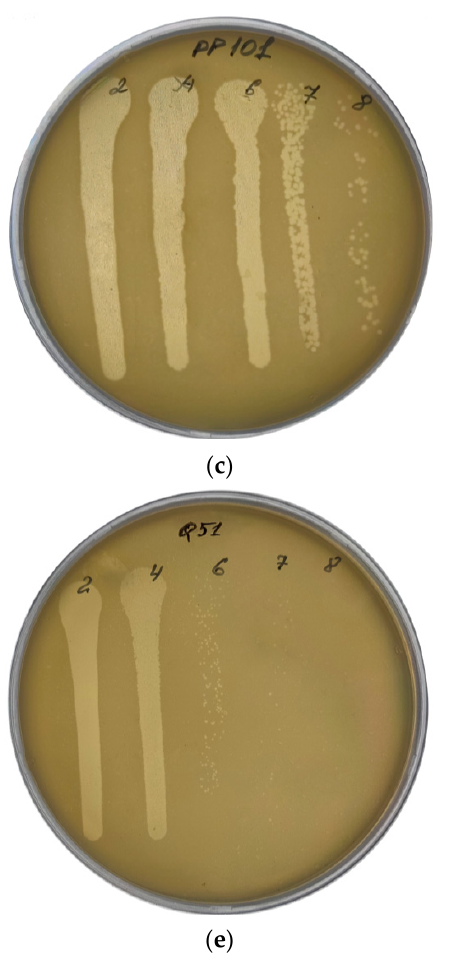
Figure 1. Plaques formed by bacteriophages comprising the phage cocktail. Each phage was applied in different concen- trations to the corresponding propagation host. The numbers indicate the dilution of the phage lysate (10-fold dilutions): ( a ) Possum/F041; ( b ) PP16/F002; ( c ) PP101/F152; ( d ) PP47/F157; ( e ) Q51/F018.